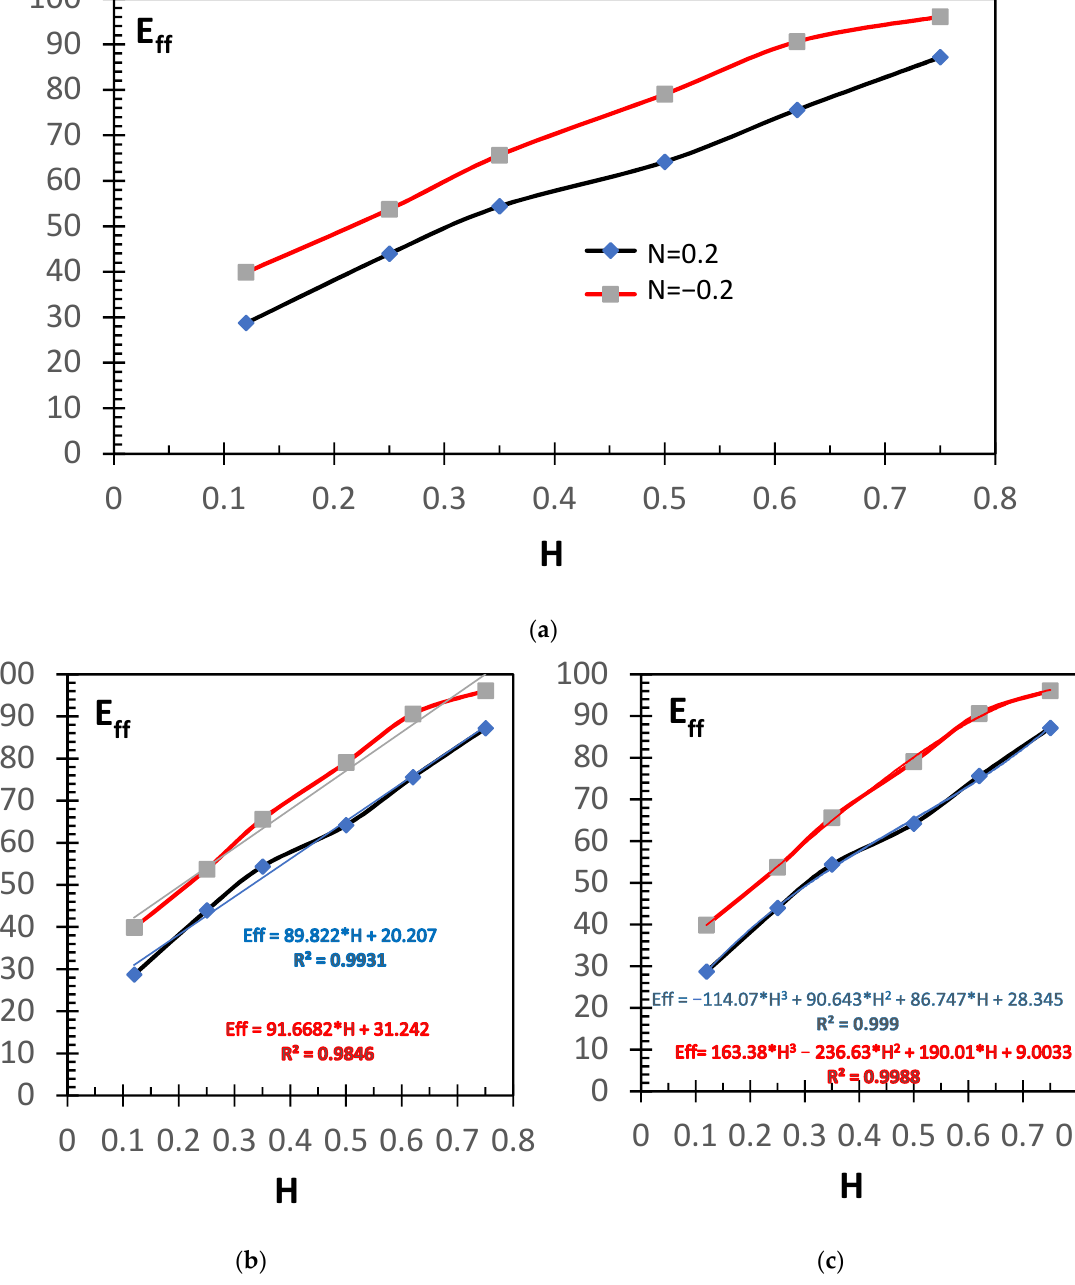
Figure 17. ( a ) Effect of the barrier height on the efficiency for Ra = 2 × 10 4 , N = 0.2 and N = −0.2; ( b ) Linear trendline to efficiency variation with the barrier height; ( c ) Polynomial trendline to efficiency variation with the barrier height, blue color equation for N = 0.2 and red color equation for N = −0.2.